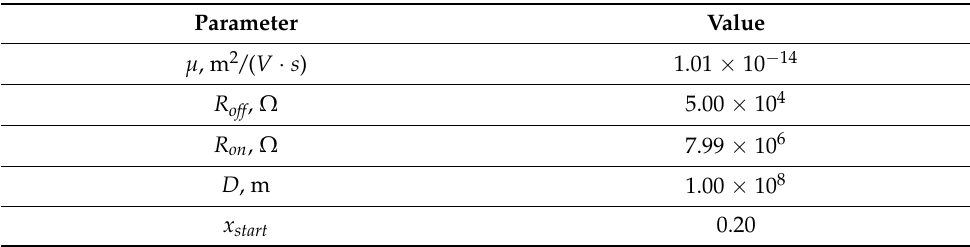
Table 4. Optimal values of linear drift model parameters obtained by approximation of the experi- mental